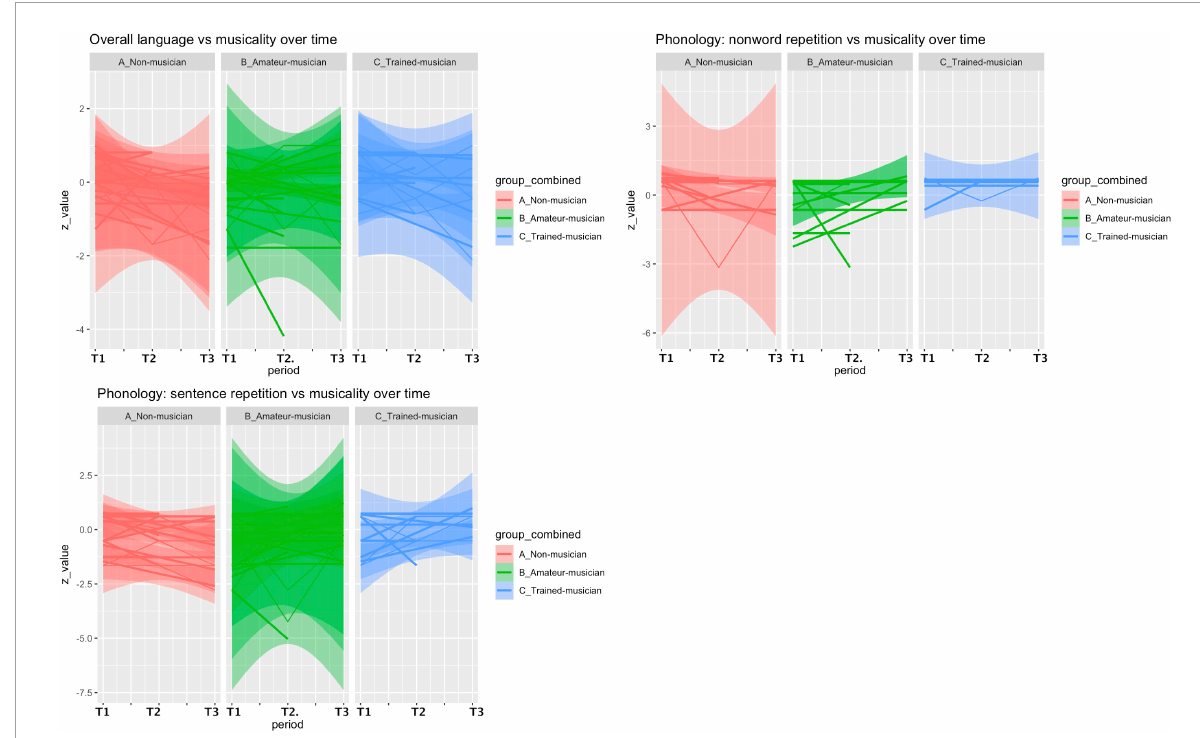
FIGURE1 Postoperative language course vs. musicality. An overall decrease of language performance (mean/SD z -value) was observed within the first three months (T1 vs. T2) in our included cohort ( n = 44, –0.255/0.966) but patients with more musical experience tended to recover better on the non-word repetition subtest (phonologic domain) (A: –0.425/0.951 vs. B: –0.001/1.14 vs. C: 0.028/0.566, p = 0.19) and the sentence repetition subtest (phonologic domain) (A: –0.202/0.683 vs. B: 0.036/1.92 vs. C: 0.125/1.32, p = 0.446).